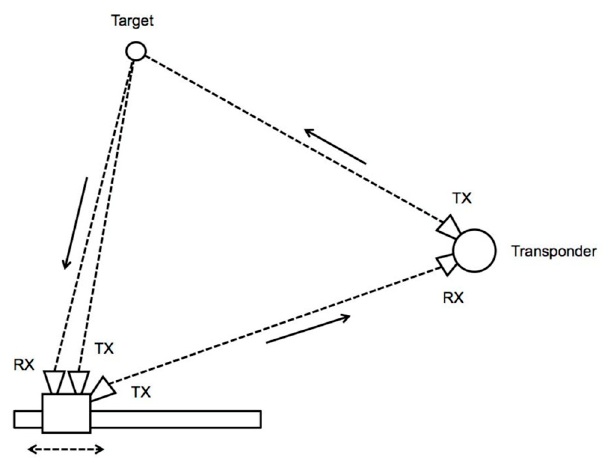
Figure 17. Bistatic GBSAR with transponder (after [30]).